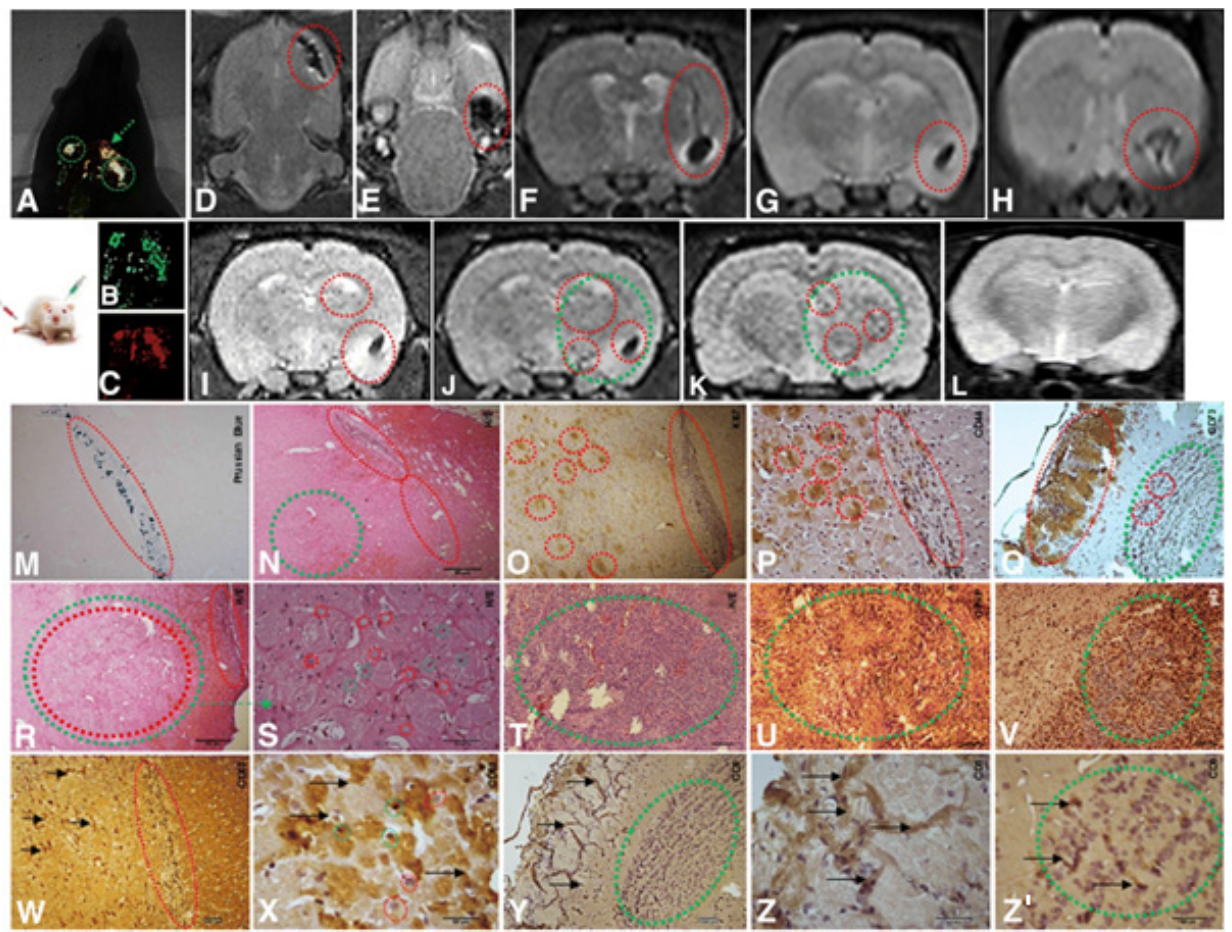
Figure 1. Implantation of 1 × 104 CD133+ GBM cells labeled Qdots (705 nm). After the establishment of the GBM (28 days), there was an infusion in caudal vein 1 × 104 MSCs (MION-Rh); the develop- ment of the tumor was followed for 20 days. ( A ) MSCs labeled MION-Rh and CD133+ GBM cells